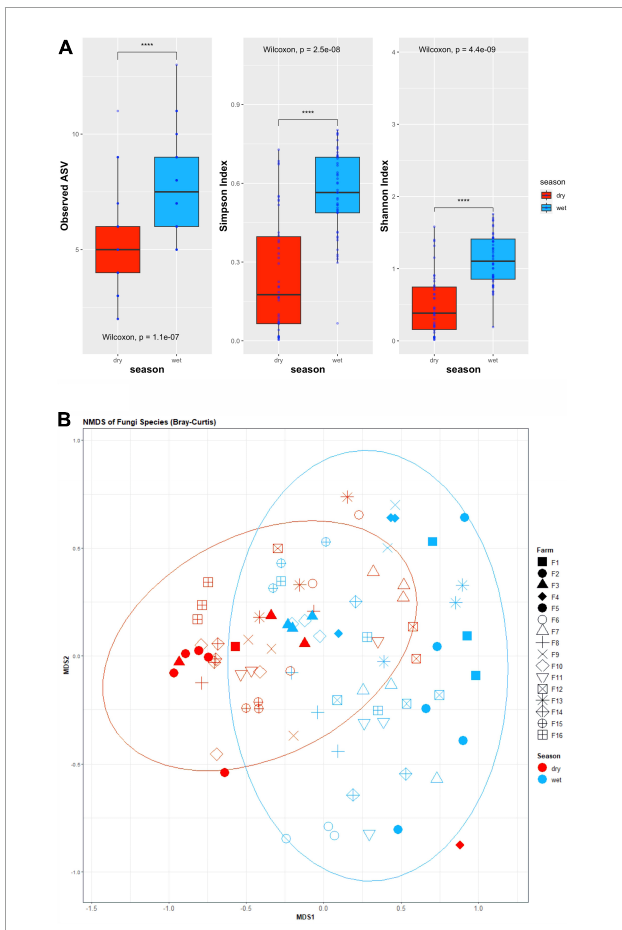
FIGURE2 (A) Boxplots of alpha-diversity indices for the mycobiota of Canastra cheeses produced in wet and dry seasons. From left to right, the boxplots show the observed species (ASV’s), Simpsons diversity index and Shannon‘s diversity index of the cheeses grouped by season. Wilcoxon rank-sum test between wet and dry season illustrates significant differences in alpha diversity between seasons; (B) NMDS plot of the Bray-Curtis dissimilarity matrix of Canastra cheeses’ mycobiota at species level. Point colors indicate season (red points indicate dry season, blue points indicate wet season) and point shapes represent the various farms sampled. **** = p -value < 0.0001.